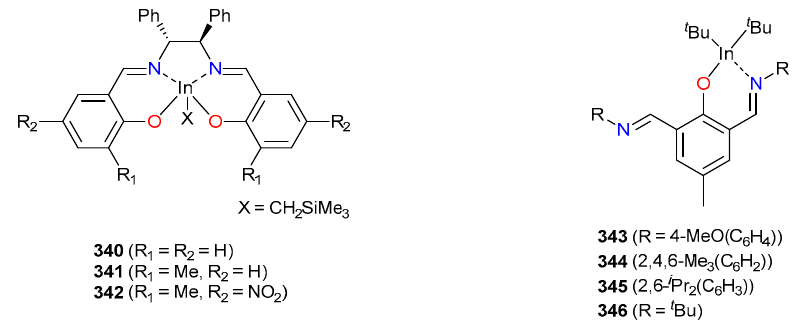
Figure 52. Indium(III) complexes 340–346 [124,143].